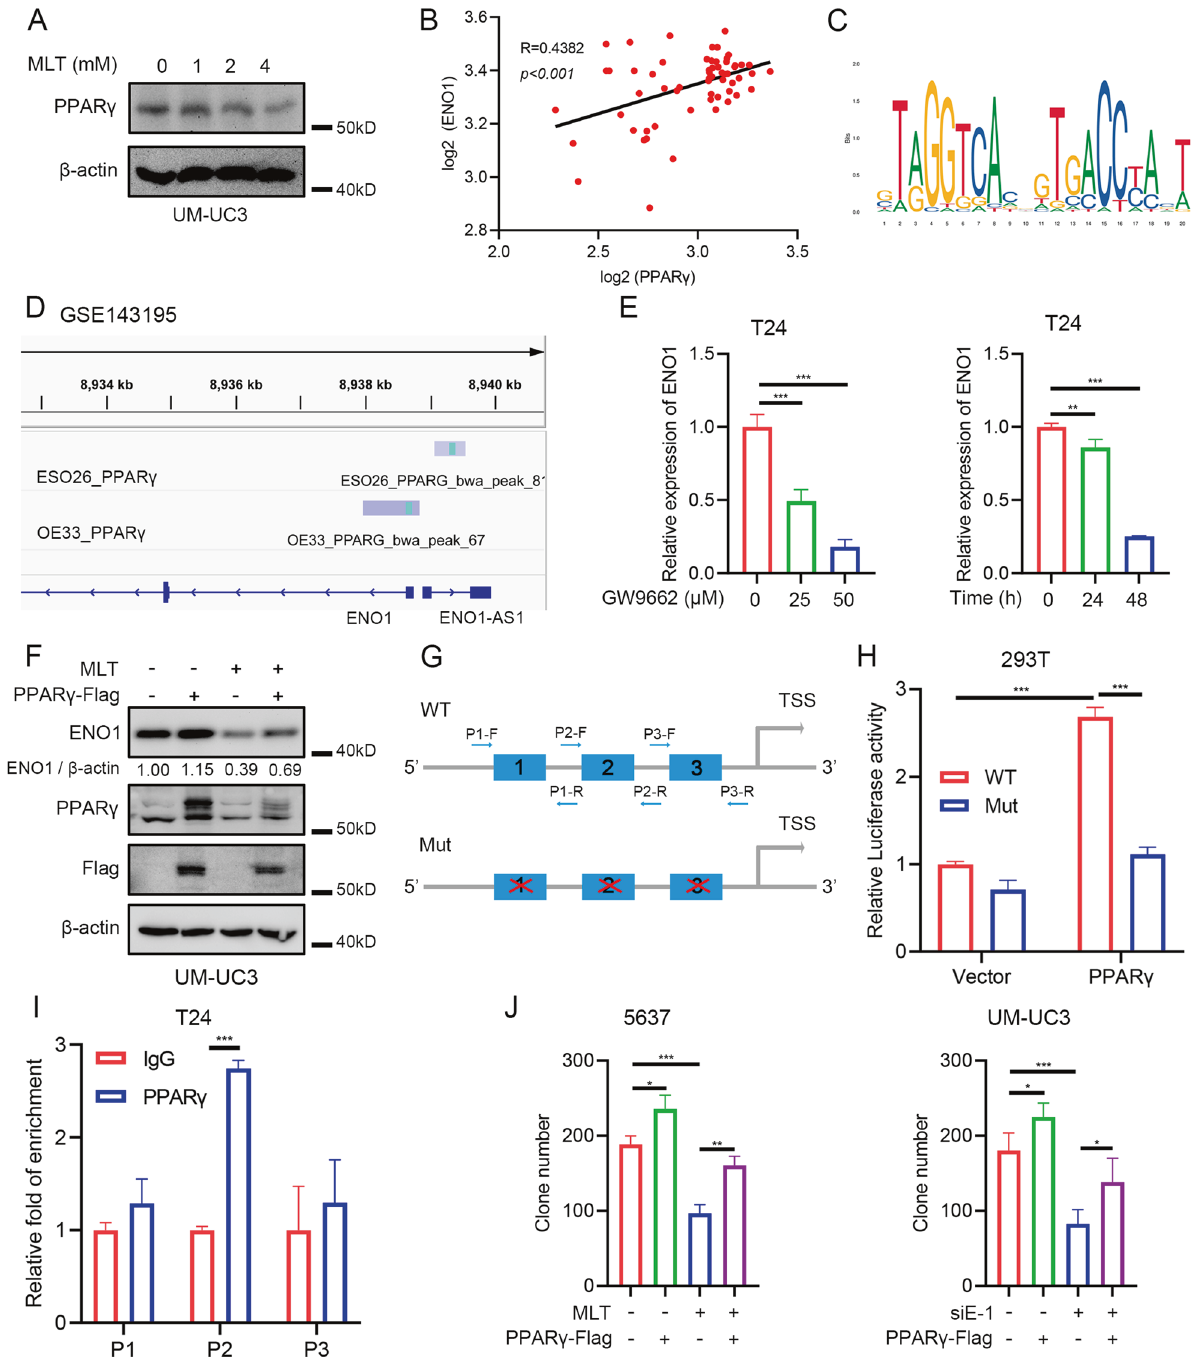
Fig. 6 PPAR γ mediated the downregulation of ENO1 by melatonin. A Western blot results of PPAR γ protein alteration with 24 h melatonin treatment. B Spearman correlation analysis of the expression level of ENO1 and PPAR γ in GSE3167. C The binding site of PPAR γ obtained from the JASPAR database. D ChIP-seq data of esophageal adenocarcinoma showing the binding of PPAR γ on ENO1 promoter region. E qRT-PCR results of ENO1 mRNA level with GW9662 treatment in T24 cells ( n = 3). F Western blot results of ENO1 protein level with PPAR γ overexpression and melatonin (4 mM) treatment, empty vector was added. G Pattern of dual-luciferase reporter construction and ChIP-qRT- PCR primer design. H Dual-luciferase reporter assay of ENO1 promoter activity ( n = 3). I ChIP-qPCR assay of putative PPAR γ binding sites on ENO1 promoter ( n = 3). J Statistical analysis of clone formation assay of 5637 cells and UM-UC3 cells ( n = 3), empty vector or negative control siRNA was added. * p < 0.05, ** p < 0.01, *** p < 0.001. which veri fi ed that melatonin interrupted the glycolysis in BLCA, exogenous pyruvate supplementation alleviated the accumula- which led to the abnormally accumulated and fatal ROS. tion of ROS and signi fi cantly rescued the proliferation and Clinical chemoresistance is a prominent obstacle to the metastatic ability of BLCA cells under melatonin treatment, treatment quality and prognosis of cancer patients. Among the